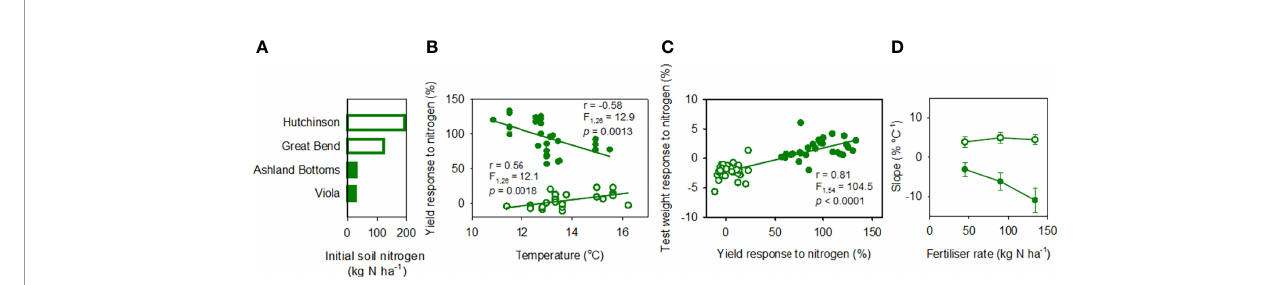
FIGURE 6 | (A) Initial NO 3 -N in soil (0 to 0.6 m) in four locations in Kansas. (B) Yield response to nitrogen fertilisation as a function of mean temperature in the critical period. (C) Association between the response to nitrogen fertiliser of test weight and yield. In (B, C) : response to nitrogen is: 100 · (X N -X 0 )/X 0 where X is the trait (yield, test weight), subscript N indicates fertilised (134 kg N ha -1 ), and subscript 0 indicates unfertilised control; lines are least squares regressions. (D) Slope ± s.e. of the lest squares regression between yield response to nitrogen fertiliser and temperature in the critical period for crops fertilised with 45, 90 or 134 kg N ha -1 . In (A – D) , open symbols indicate high (> 120 kg N ha -1 ) and closed symbols low initial nitrogen (< 20 kg N ha -1 ).